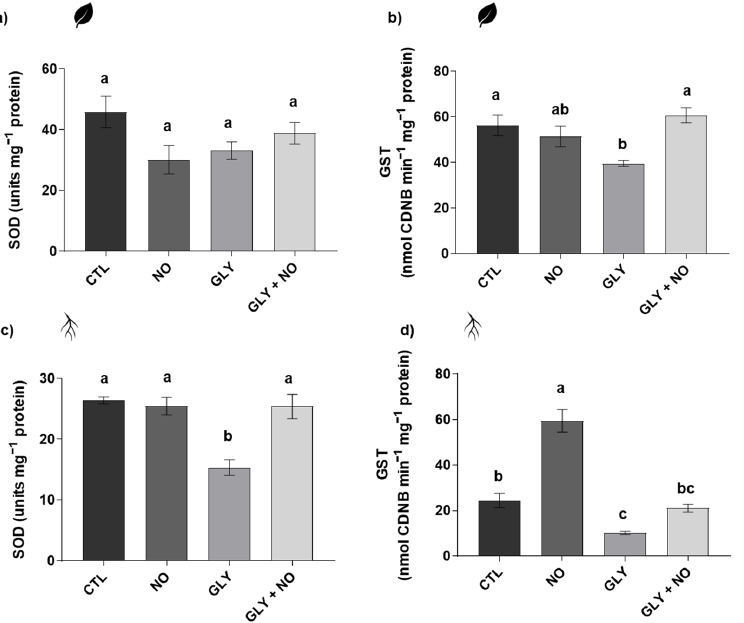
Figure 3. Activity of antioxidant enzymes of Solanum lycopersicum L. cv. Micro-Tom grown for 28 days in an artificial soil contaminated by GLY (10 mg kg − 1 ) and/or foliar sprayed with SNP (200 µM): ( a , c ) superoxide dismutase (SOD) and ( b , d ) glutathione-S-transferase (GST). CTL—control plants, grown in the absence of GLY and foliar sprayed with dH 2 O once a week (black); NO—plants grown in the absence of GLY and foliar sprayed with SNP once a week (dark grey); GLY—plants grown in the presence of GLY (grey); GLY + NO—plants grown in the presence of GLY and weekly sprayed with SNP (light grey). Results are presented as mean ± standard deviation (SD) and result from the evaluation of at least three experimental replicates ( n ≥ 3). Different letters above bars indicate significant differences between groups (CTL, NO, GLY and GLY + NO) at p ≤ 0.05, according to the one-way ANOVA followed by Tukey’s post hoc